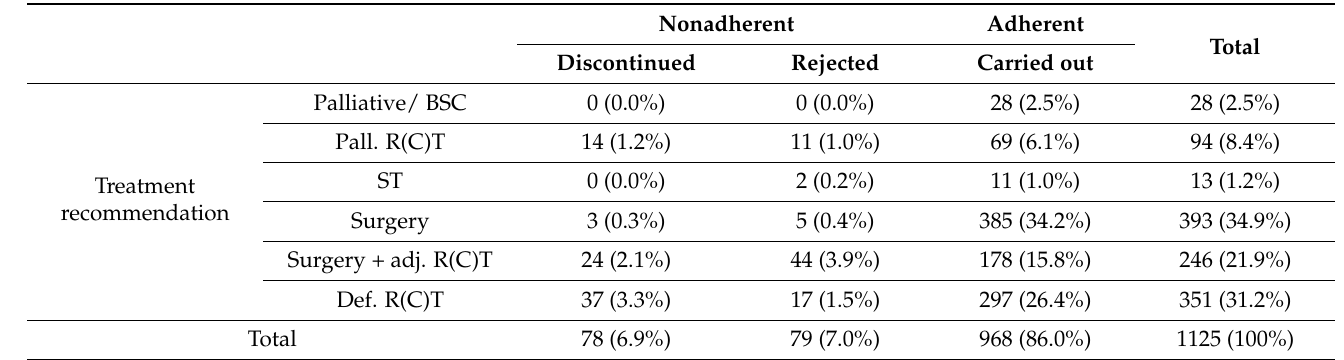
Table 3. Cross-table comparing the therapy recommended by the tumour board to the implementation of the therapy.